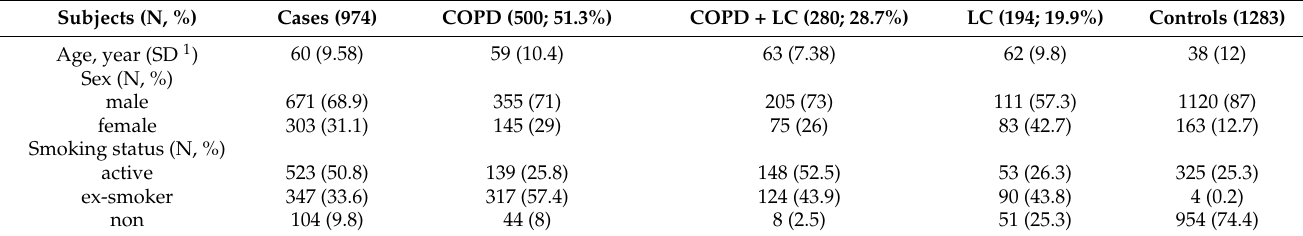
Table 1. Demographic characteristics of the tested population.